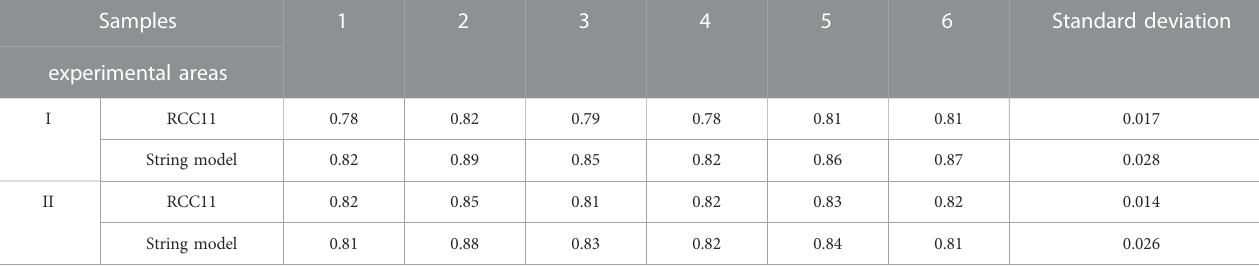
TABLE 11 Statistical table of the average matching rate of different spatial relations.